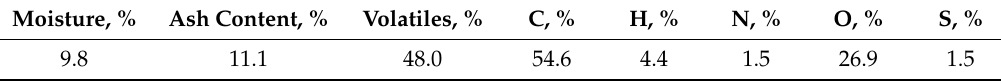
Table 2. Physicochemical characteristics of brown coal.